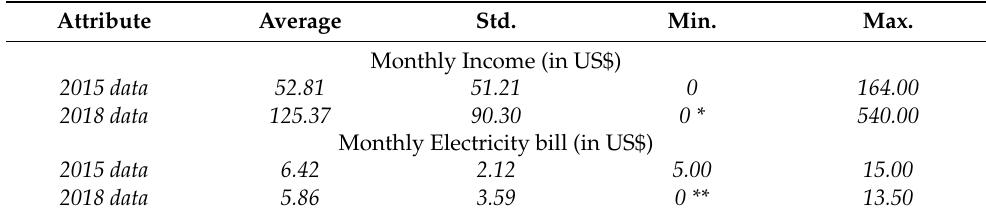
Table 3. Comparison of monthly income and electricity cost in Pangan-an. 2015 [59] vs. 2018 (surveyed). Attribute Average Std. Min. Max. Monthly Income (in US$)